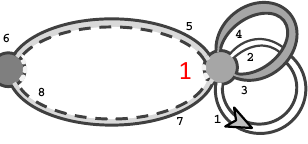
Figure 6 . The ribbon graph corresponding to figure 5. It is specified by the permutations (cid:11) = (1 2)(3 4)(5 6)(7 8) , (cid:27) = (^1 3 2 4 5 7)(6 8) on the set of half-edges H = f 1 ; 2 ; : : : ; 8 g . The two paths required to cover the graph are shown as a dashed line and as a continuous line. This graph therefore has two